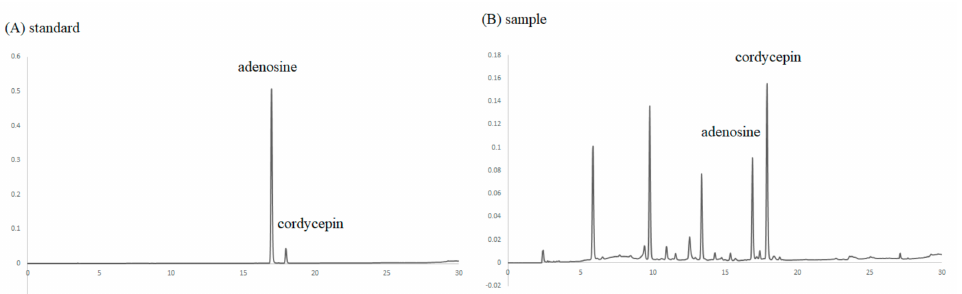
Figure 1. HPLC analysis of adenosine and cordycepin in the cordycepin-rich supernatant. Chro- matogram of ( A ) standard and ( B ) cordycepin-rich